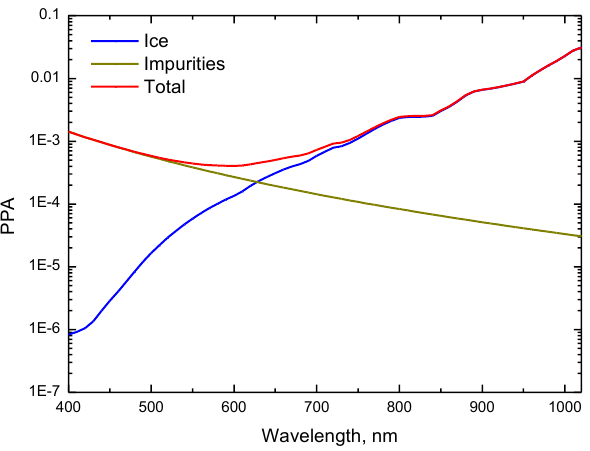
Figure 1. The intercomparison of theory (symbols) with experi- mental measurements of plane albedo (line, no noise removed) per- formed in the French Alps (45 ◦ 2 (cid:48) N, 6 ◦ 2 (cid:48) E; 2100ma.s.l.) obtained on 12 April 2017. The plane albedo is an average of five measure- ments performed between 08:55 and 09:30UTC for a polluted (by dust) snowpack. The solar zenith angle for the measurements was between 47 and 49 ◦ . The noise of measurements has not been re- moved and is clearly seen in the near-infrared portion of the spec- trum.